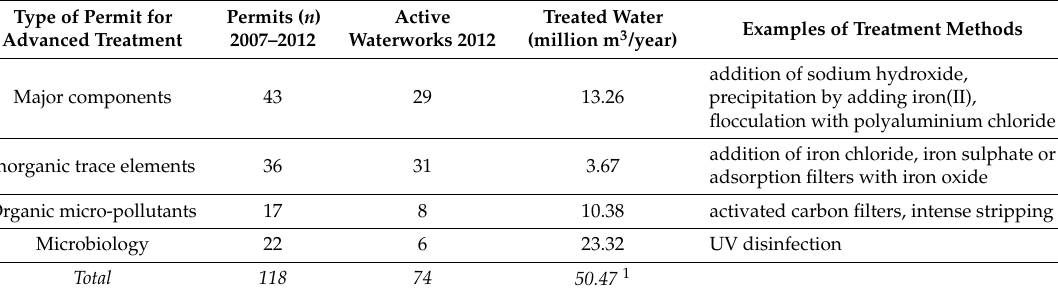
Table 1. Granted permits for advanced water treatment in Denmark (2007–2012). From those, number of active waterworks by 2012 and volumes of treated water produced yearly